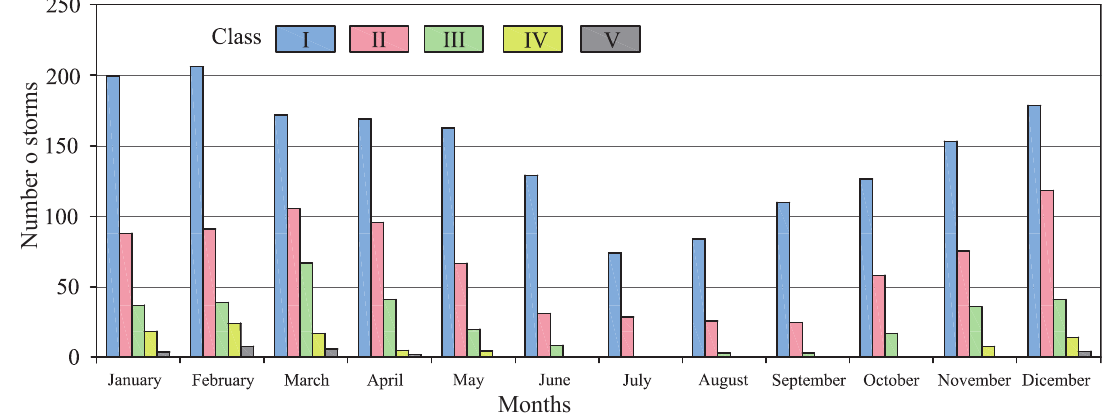
Figure 6. Monthly distribution of all storm events per class and month.